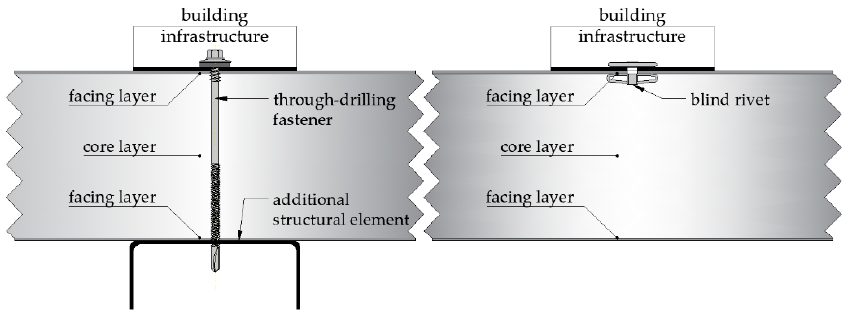
Figure 1. Schemes of the connections of the building infrastructure with the sandwich panel via a through-drilling fastener and a blind rivet.